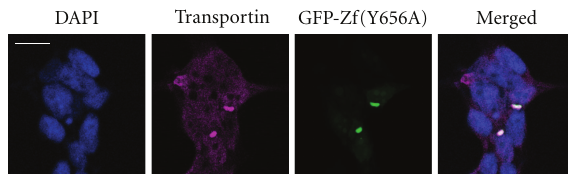
Figure 3: Colocalization of transportin-1 (in magenta) and GFP- Zf(Y656A) (in green). Nuclei are shown by DAPI staining (in blue). Bars, 15 μ m. Representative examples of the subcellular localization are shown (all cells expressing the constructs are showing the indicated